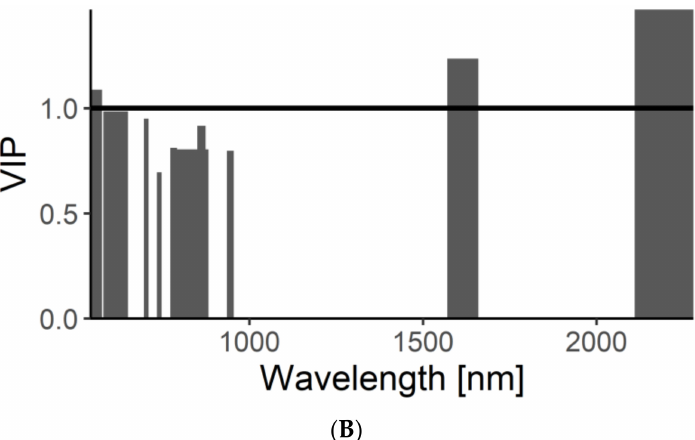
Figure 14. Measured against predicted soil organic carbon content (SOC) in the flight line of the hyperspectral Airborne Prism Experiment (APEX) sensor with a Cellulose Absorption Index (CAI) threshold at 0.75, where spectra were resampled to Sentinel-2 radiometric resolution. The blue line is the 1:1 line, the red line is the regression line ( A ) with its variance importance in projection (VIP) scores ( B ). Predictors with VIP values greater than one (bars reaching above the horizontal line in the plot) were considered significant for the PLSR model.